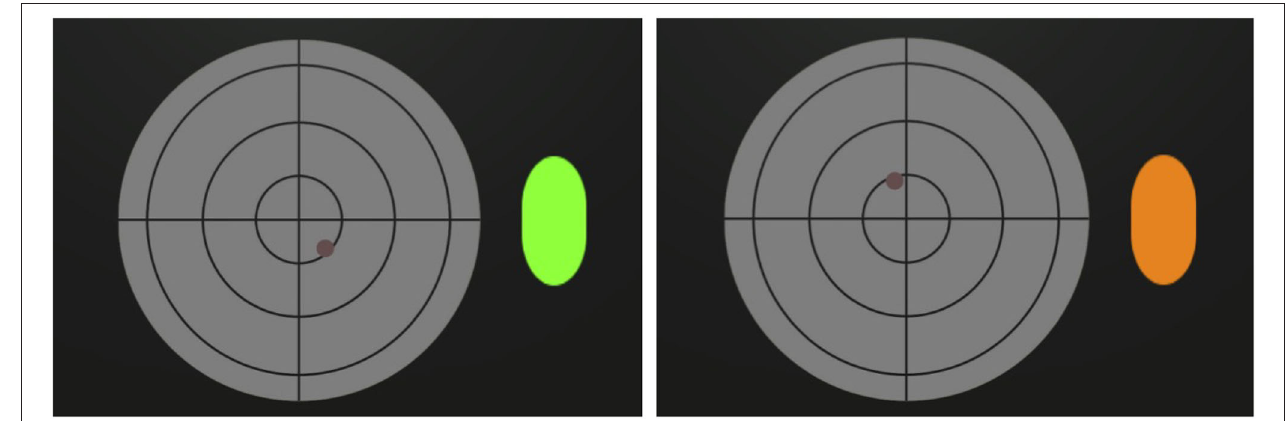
FIGURE 3 | (Left) The pBCI detected that the pilot was correctly monitoring the radar and, in return, displayed a green visual feedback. (Right) The pBCI detected that the pilot did not notice the potential collision. It then displayed an orange warning and automatically simulated the avoidance maneuver.